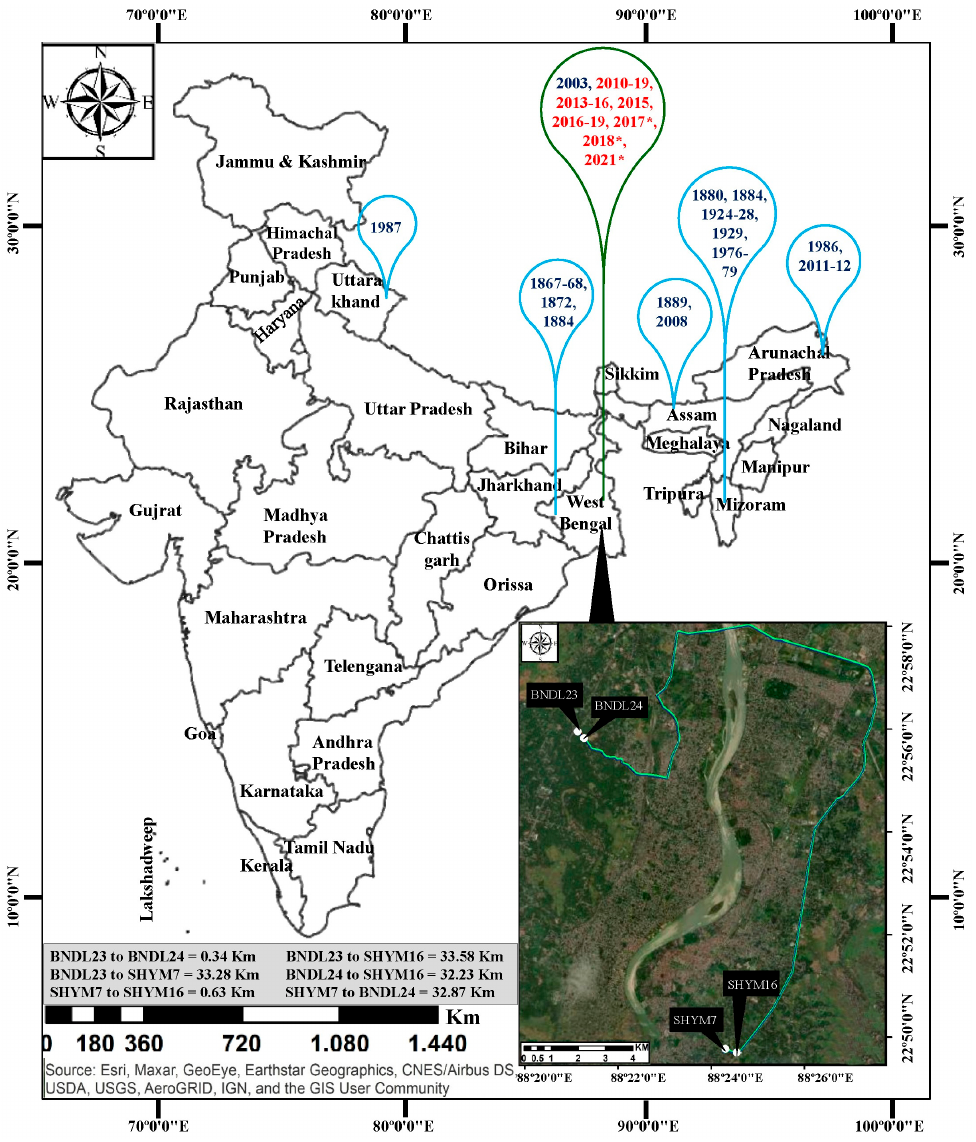
Figure 1. Gregarious and sporadic flowering incidents of B. tulda previously reported from different regions of India and the study sites used in these analyses. Data sources for Map: Esri, Maxer, GeoEye, Earthstar Geographics, CNES/Airbus DS, USDA, USGS, AeroGRID, IGN and the GIS user Community. Blue bubbles represent gregarious flowering, and green bubbles represents sporadic flowering events (Troup, 1921; Perry, 1931; Mohan Ram and Gopal, 1981; Rawat, 1987; Gupta, 1987; Naithani, 1993; Bhattacharya et al., 2006; Sarma et al., 2010; Naithani et al., 2013). Those with a flowering cycle that continued until June, 2021, have been marked with asterisks. Flowering year marked in red font identified in this